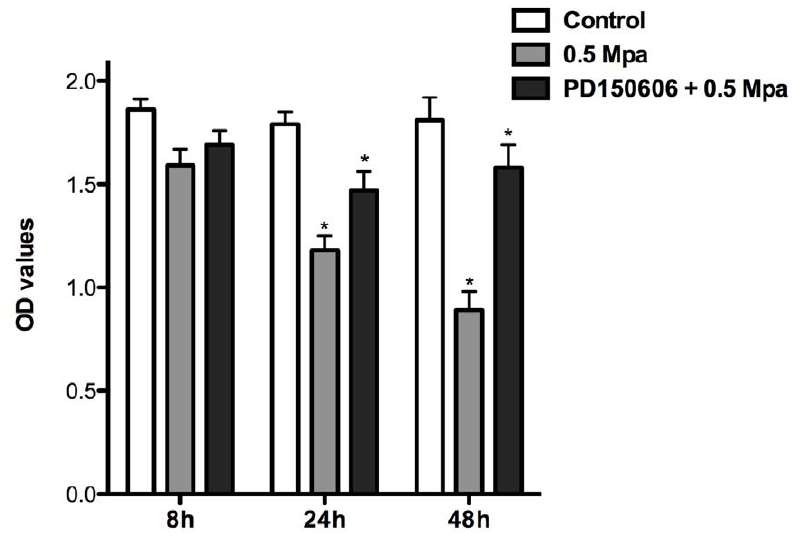
Figure 2. Effects of mechanical force on cell viability of DRG neurons. Compared with control cells, the OD values of DRG neurons treated with 0.5 MPa of pressure were significantly lower at 24 and 48 h after pressure treatment OR injury (P , 0.05, n=5). The OD values at 24 and 48 h after pressure treatment in cells treated with PD150606 + 0.5 MPa of pressure were significantly higher than those treated with 0.5 MPa of pressure alone (P , 0.05,